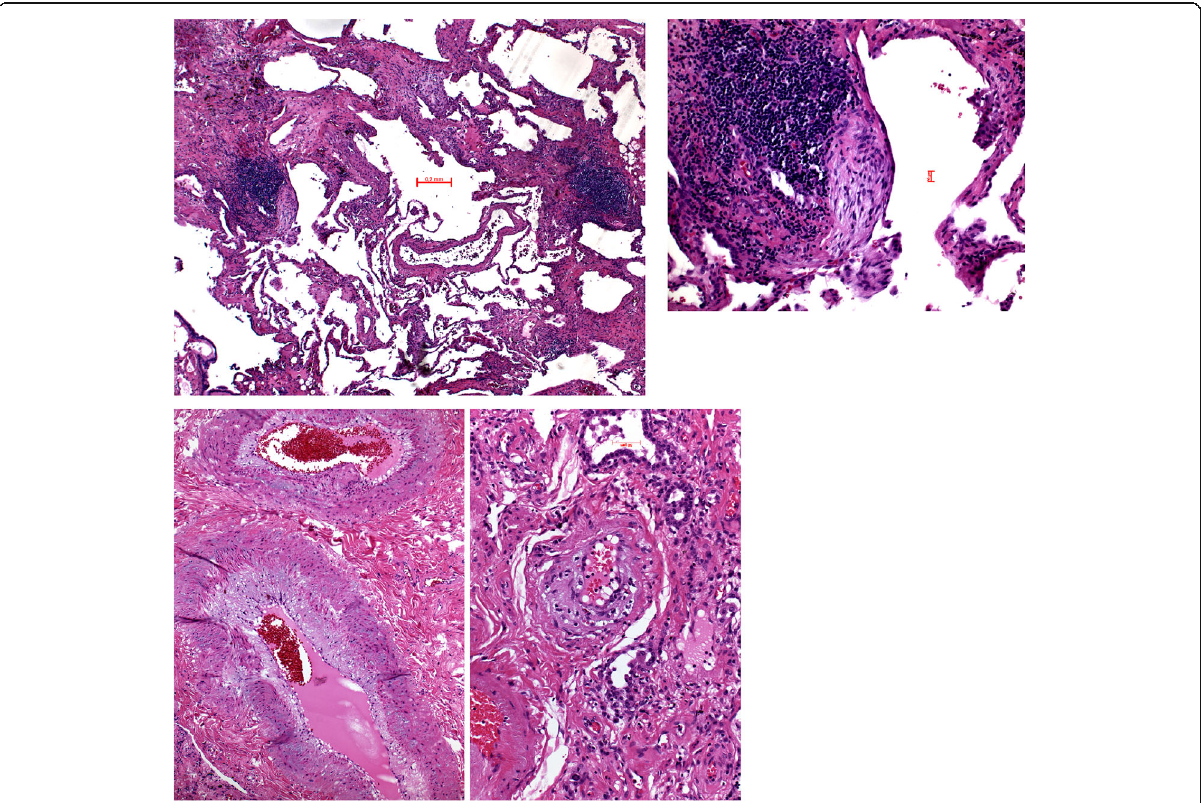
Fig. 17 Chronic systemic sclerosis (SSc); UIP pattern with myofibroblastic focus, fibrosis, cystic remodeling, but also hyperplasia of BALT. Note the dense lymphocytic infiltration into the myofibroblastic focus (top); at the bottom vasculopathy is seen with myxoid changes of the intima and narrowing of the arterial lumen. H&E, bars 200, 50, and 20 μ